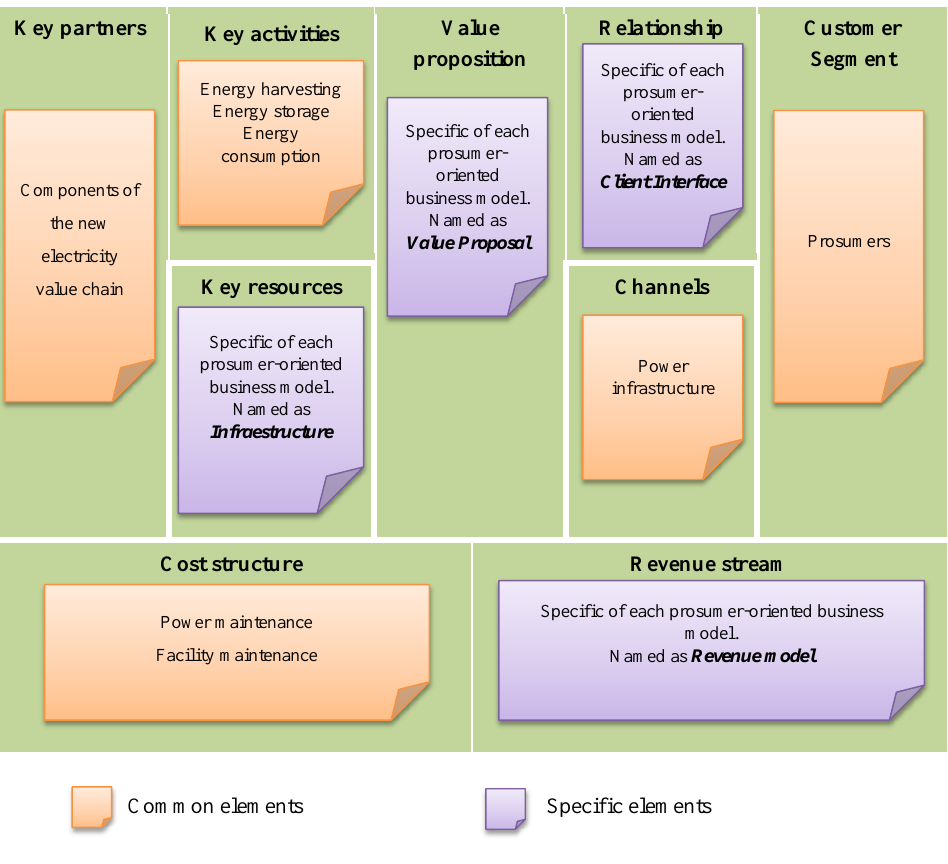
Figure 4. Elements of the business model canvas.